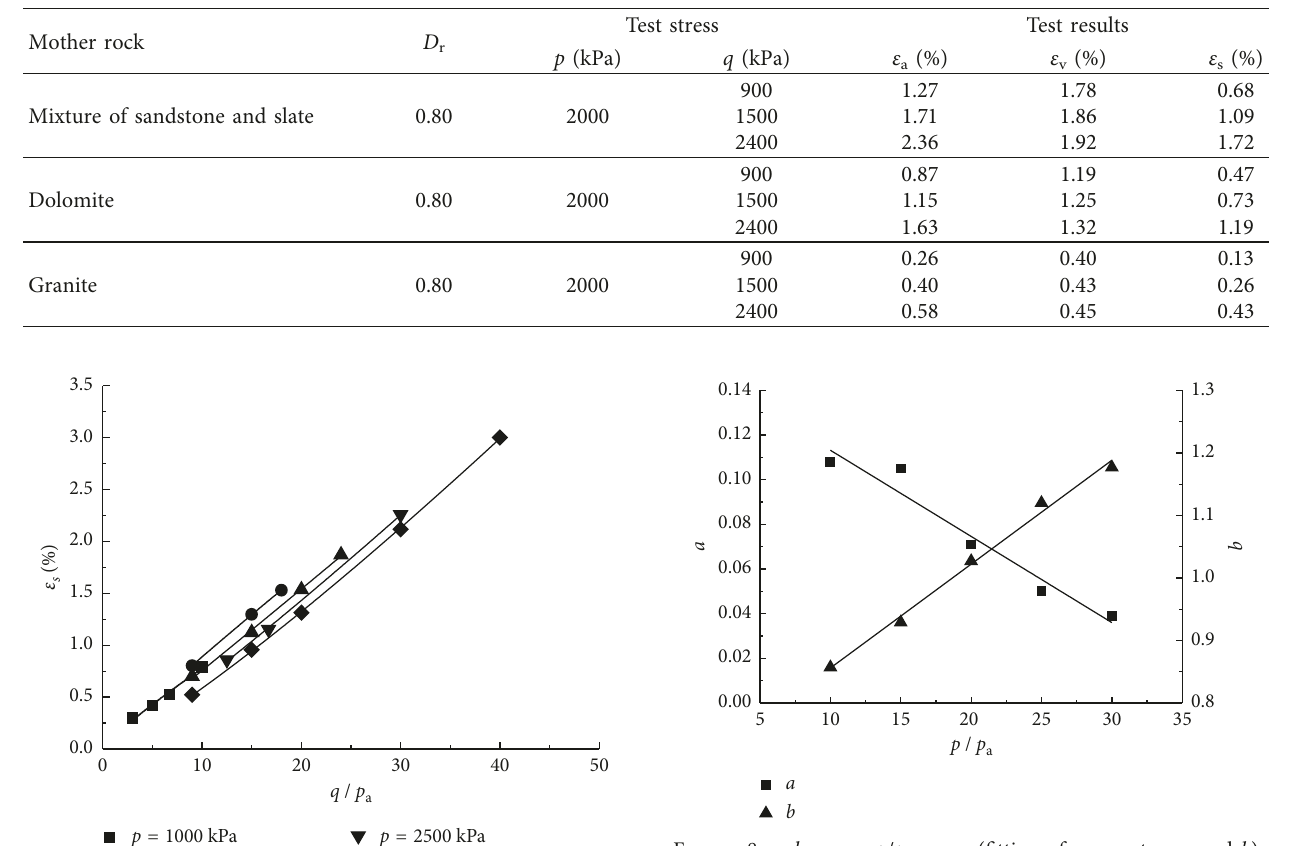
Figure 8: a , b versus p / p a curve (fitting of parameters a and b